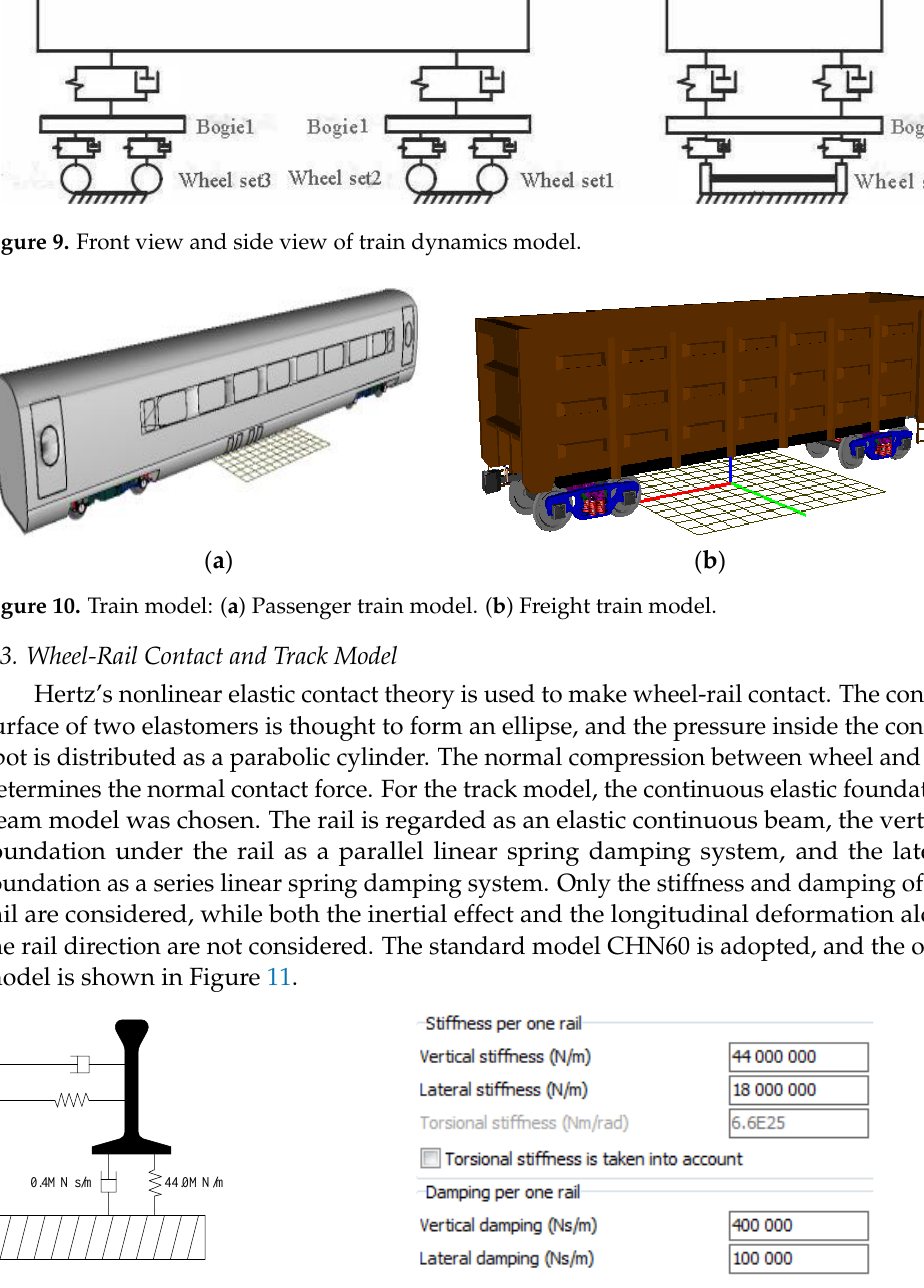
Figure 11. Orbital dynamics model and parameter setting.